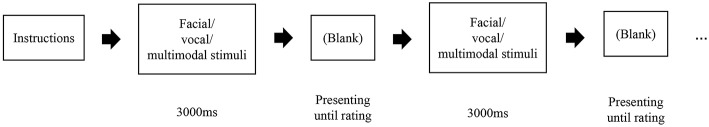
The procedure of presenting facial/vocal stimuli in Study 1 and multimodal stimuli in Study 2.